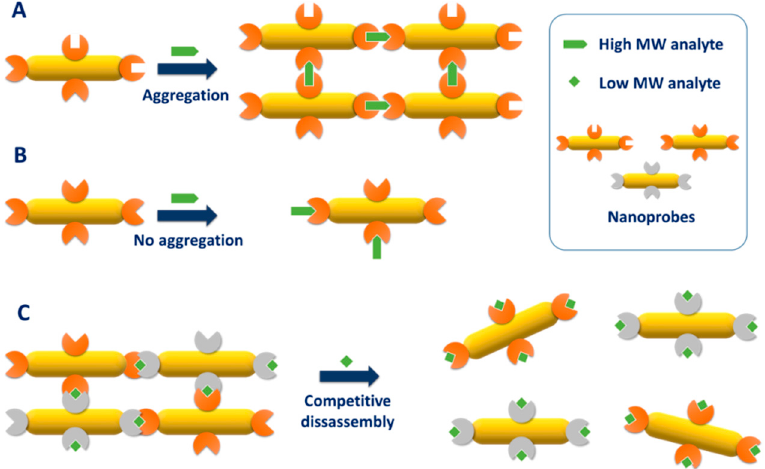
Figure 24. Immunosensor configurations. ( A ) Polyclonal antibody and high molecular weight analyte; ( B ) monoclonal antibody and high molecular weight analyte; ( C ) antibody and low molecular weight analyte.